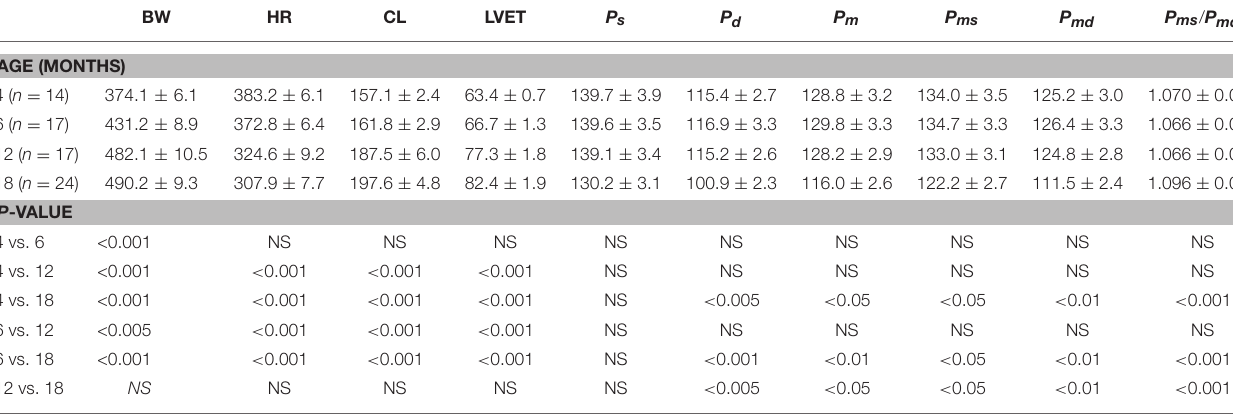
TABLE 1 | Basic hemodynamic data measured in rats aged 4, 6, 12, and 18 months.